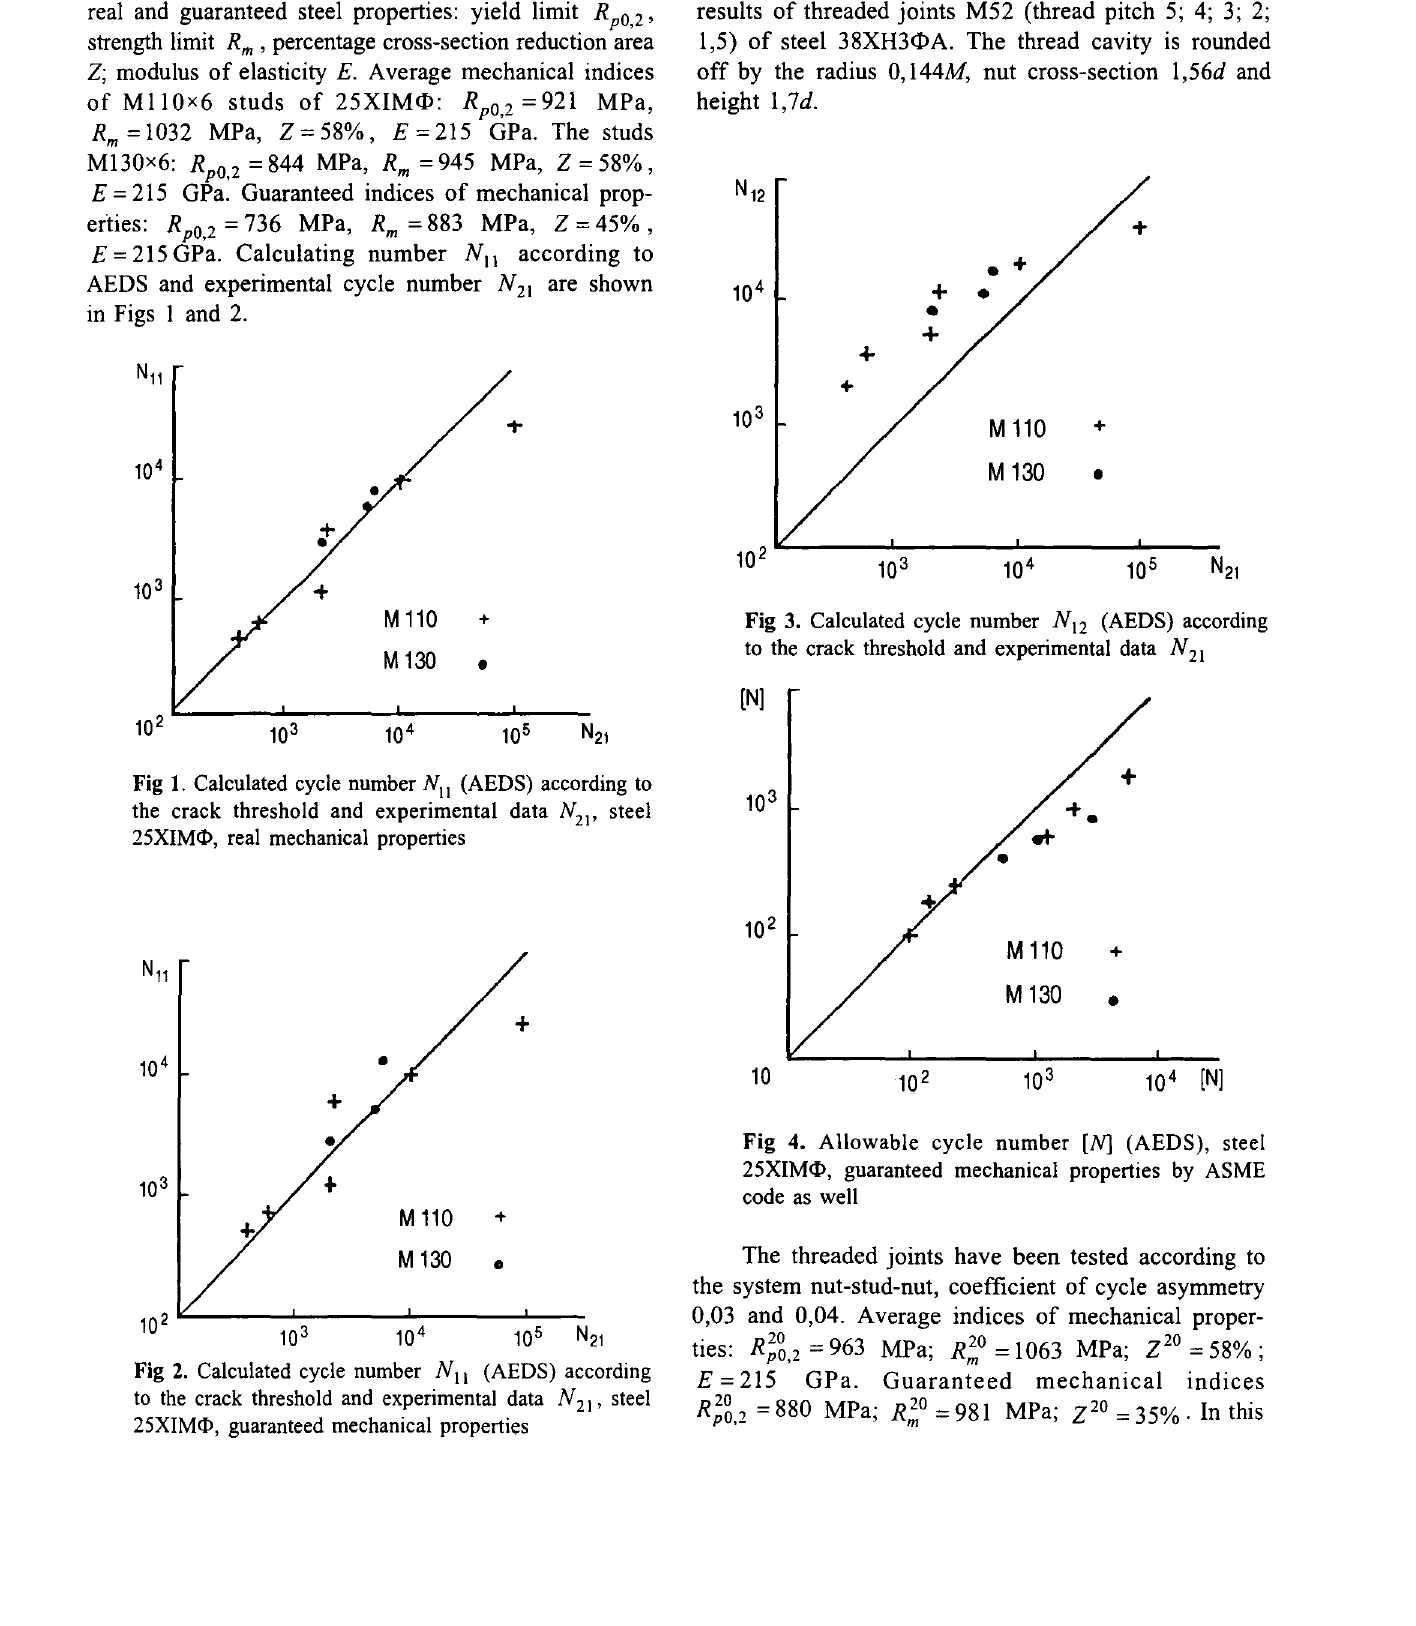
Fig 2. Calculated cycle number N to the crack threshold and experimental data N 25XIMtl>, guaranteed mechanical properties